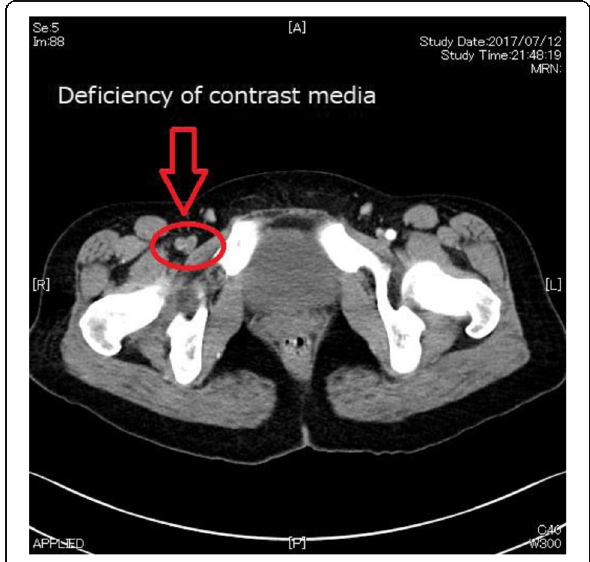
Fig. 1 Contrast-enhanced computed tomography (CT) showing a deficiency of contrast media at the right femoral